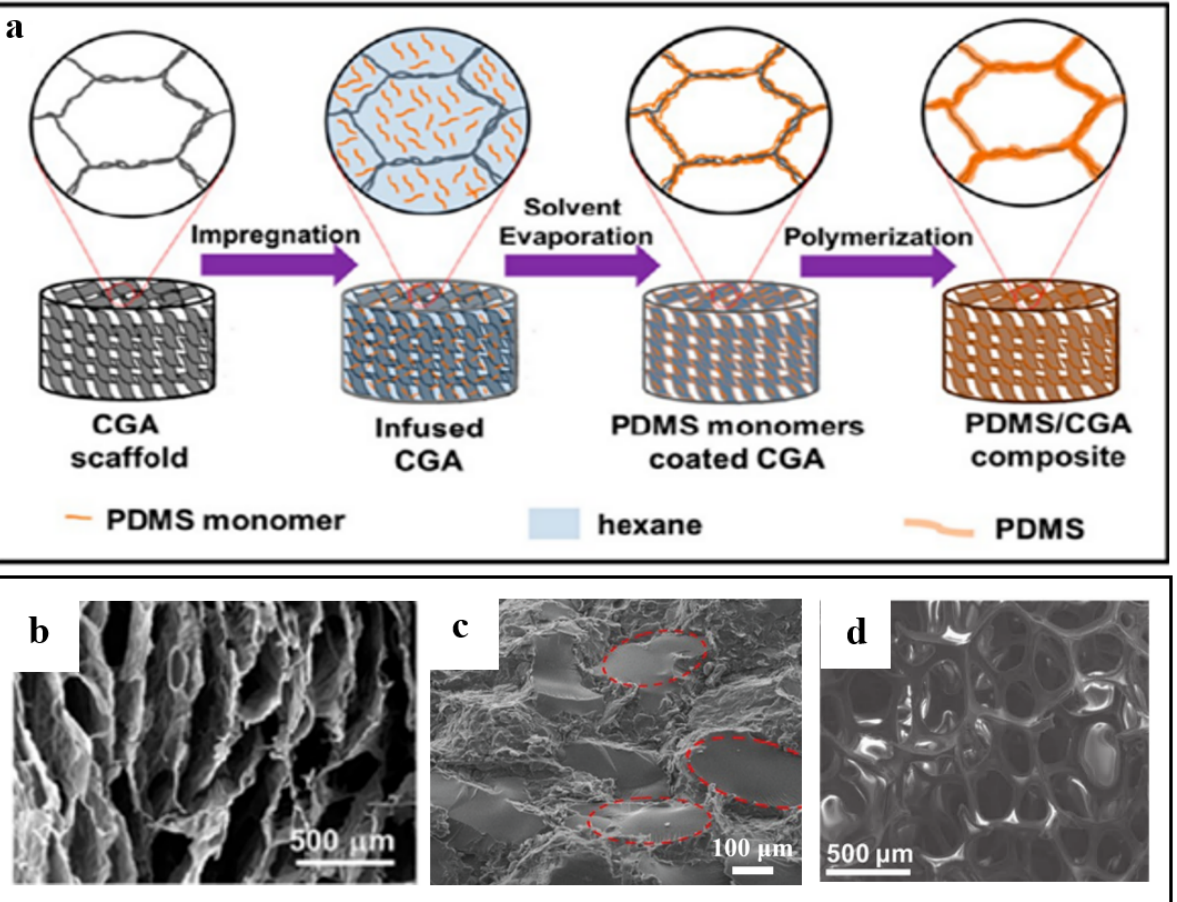
Figure 4. ( a ) Schematic of the procedure for fabricating graphene/PDMS aerogel. ( b ) The SEM image of graphene/PDMS aerogel. Reproduced with permission from [61]. ( c ) Microstructure of 3D GNPS/RGO foam/epoxy nanocomposites. Reproduced with permission from [62]. ( d ) The SEM image of graphene/PDMS foam composites. Reproduced with permission from [63].